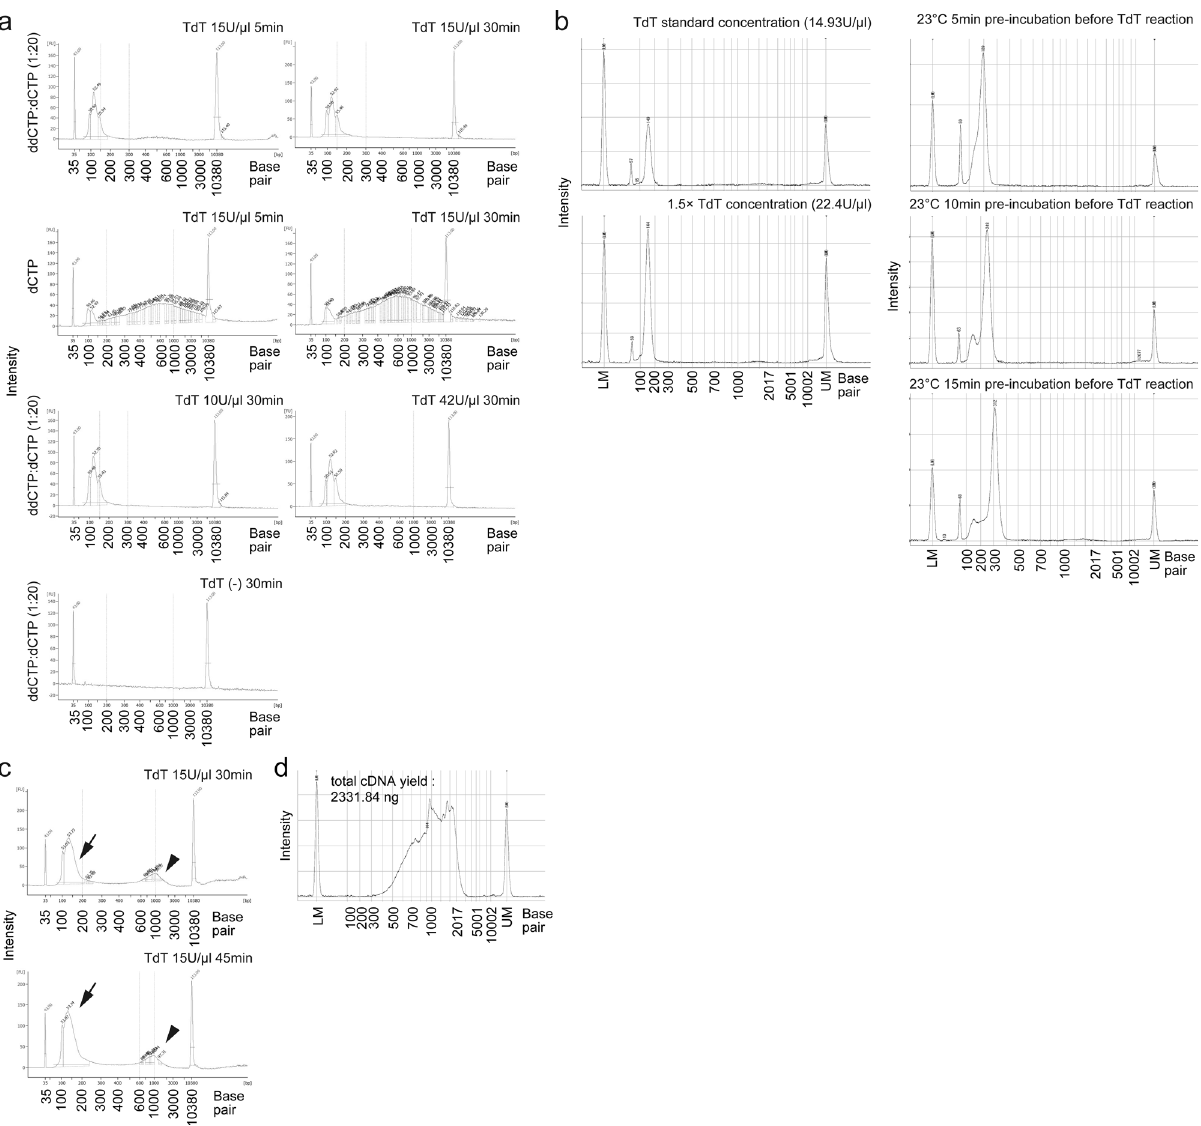
Fig. 2 TAS-Seq effectively suppresses excessive elongation of primer-derived by-products under various TdT reaction conditions. a and c TAS-Seq tolerance against TdT reaction time and TdT activity. TdT reaction with ddCTP:dCTP (1:20) or dCTP only with Co 2 + supplementation was performed from 5 or 30 or 45 min with different TdT enzyme amounts against exonuclease I-treated BD Rhapsody beads ( a ) or cDNA-synthesized, exonuclease I-treated BD Rhapsody beads ( c ). Size distributions of the 1st PCR products were analyzed. Note that the length of primer-derived bi-products (arrows) peaked at around 136 bp and did not extend over 200 bp in every reaction time. In addition, ampli fi ed cDNA was also visible ( c , arrowheads). b Quartz-seq2 tolerance against TdT reaction warming and enzyme activity. Size distribution of remained primer-derived by-products of Quartz-seq2 under standard conditions, and under pre-incubation at 23 °C for 5, 10 min, and 15; 1.5× TdT amount shown. Reactions were performed without RNA. Note that primer-derived by- products were extended over 200 bp with 23 °C pre-incubation. d Size distribution of TAS-Seq ampli fi ed cDNA library of 6000 single cells derived from the murine lung. a – d Representative results of two independent experiments are compared to Smart-seq2 data, which is based on full-length RNA- seq, TAS-Seq detected more overall and highly variable genes in ~1/5 sequencing depth (Fig. 3b, c). We further compared scRNA- seq data of single-cell suspension of adult murine kidney and spleen obtained by TAS-Seq with Smart-seq2/10X v2 data from Tabula Muris Consortium 4 . Similar to murine lungs, TAS-Seq detected more genes and highly variable genes than the other datasets in mouse whole kidney (Supplementary Fig. 3a, b) and spleen (Supplementary Fig. 3c – e). These results indicated that TAS-Seq might detect more genes and highly variable genes than 10X v2 and Smart-seq2, at least in adult murine lung, kidney, and spleen in steady-state conditions.